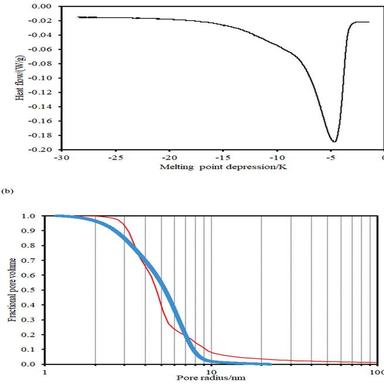
(a) raw water DSC melting curve, and (b) corresponding cumulative thermoporometry PSD (●) obtained using eq. compared with PSD from mercury intrusion (red solid line), for whole pellet sample of alumina extrudate E2.